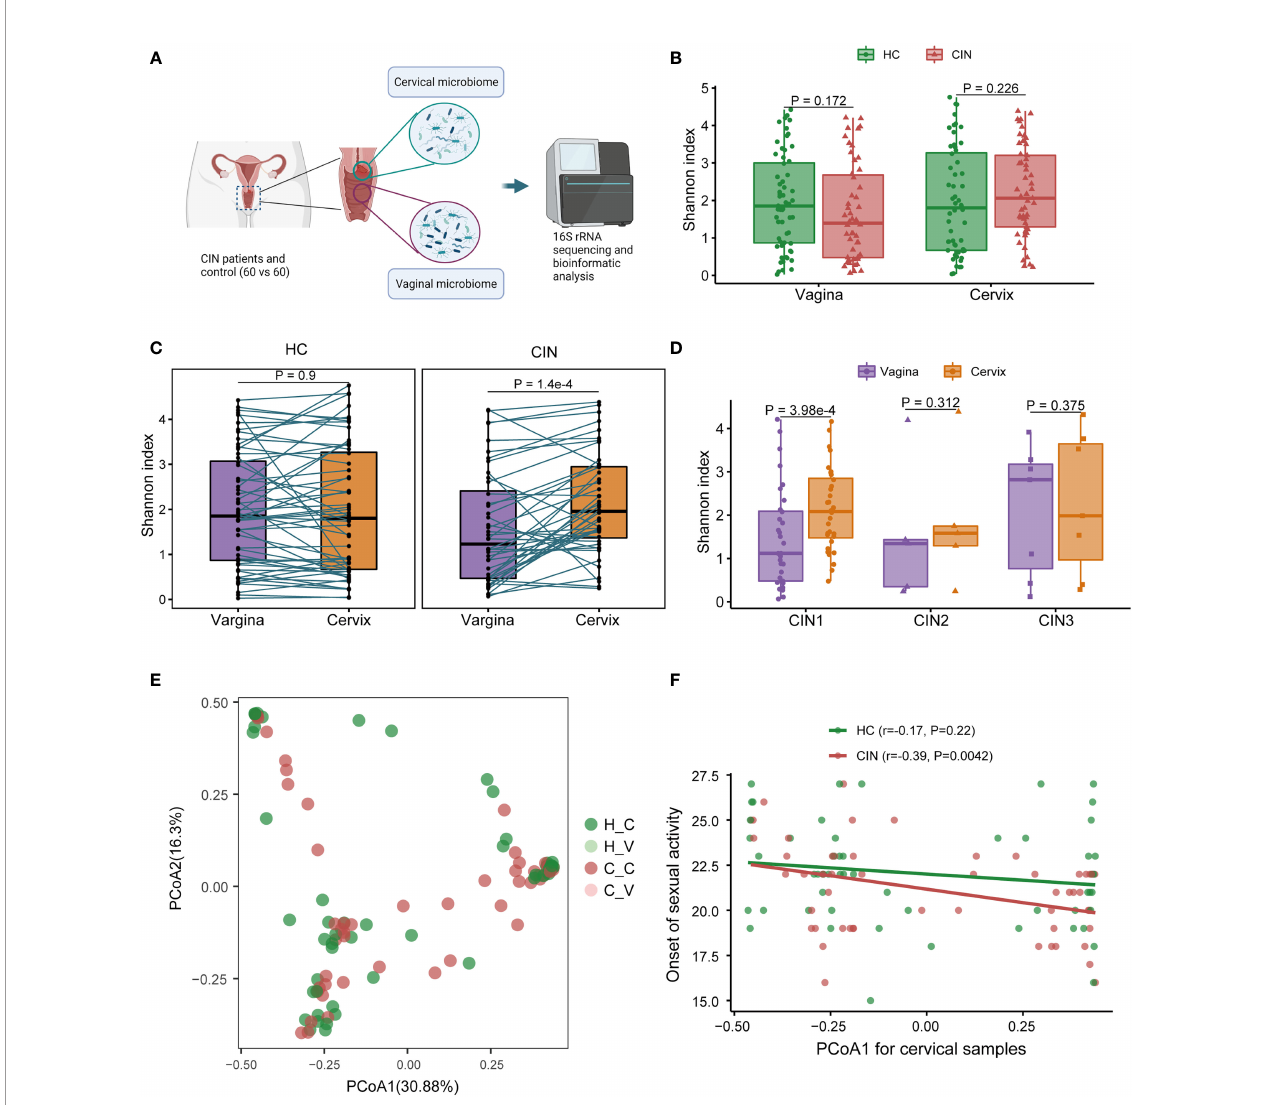
FIGURE 1 | Vaginal and cervical microbial diversity change associated with cervical intraepithelial neoplasia (CIN). (A) Schema for the study design. (B) Microbial diversity associated with CIN in the vagina and cervix. (C) Comparison of microbial diversity across the vagina and cervix. (D) Microbial diversity between the vagina and cervix in different CIN subtypes. (E) Principal coordination analysis (PCoA) result for microbial community. (F) Correlation between PCoA1 and onset of sexual activity in the